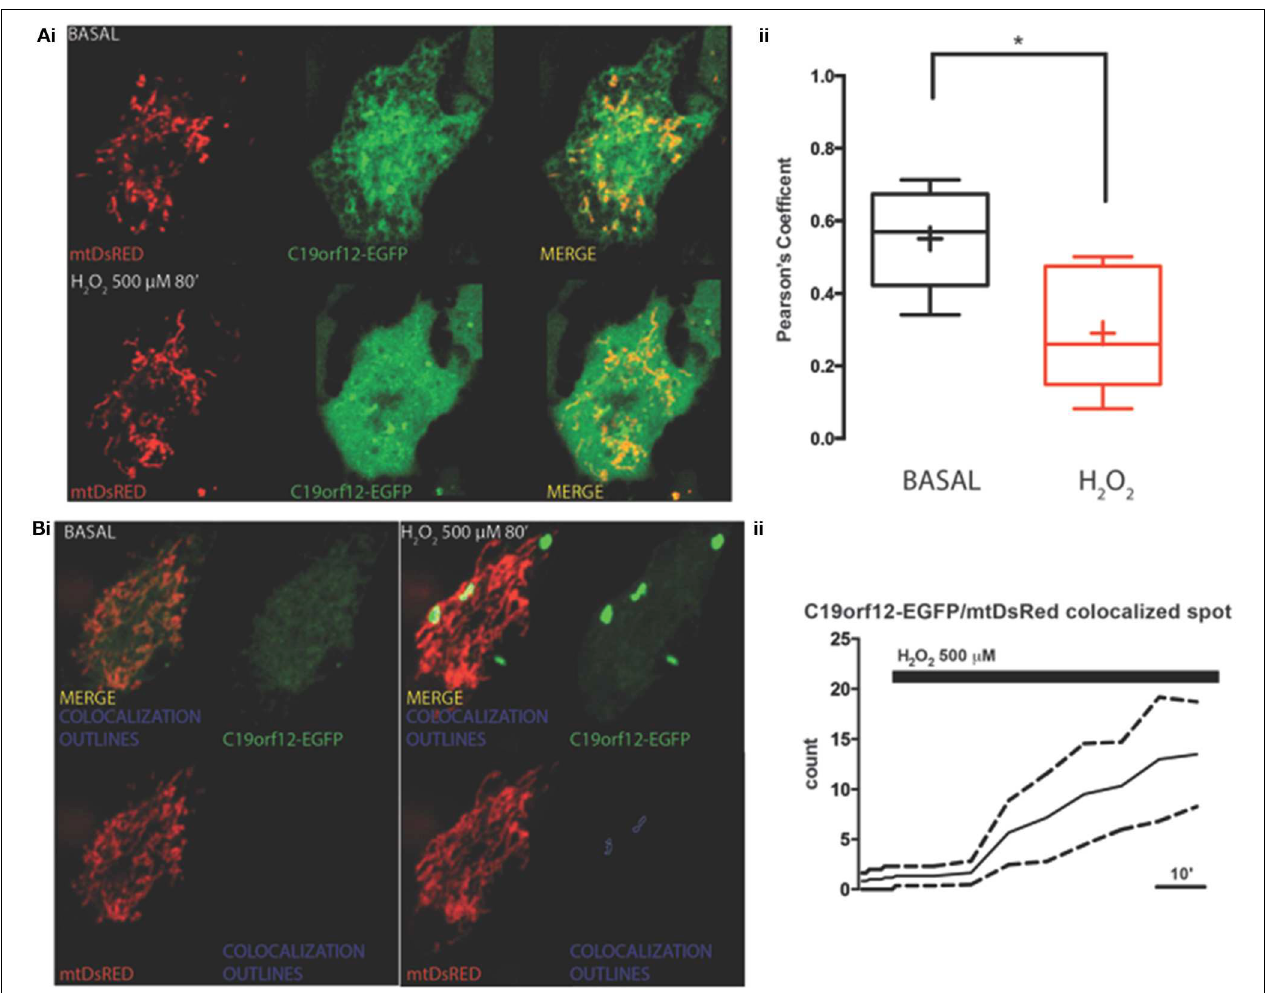
FIGURE 3 | Redistribution of C19orf12 during oxidative stress. (Ai) Representative images of HeLa cells overexpressing the C19orf12-EGFP fusion protein and the mitochondrial marker mtDsRED before (upper panel), and after (lower panel) exposure to H 2 O 2 500 µ M. (ii) Quantitative analysis of EGFP and DsRED signal before and after oxidative stress (cross, average; line, median; box, 25 and 75 percentile; bars, max and min value, n = 8 ,